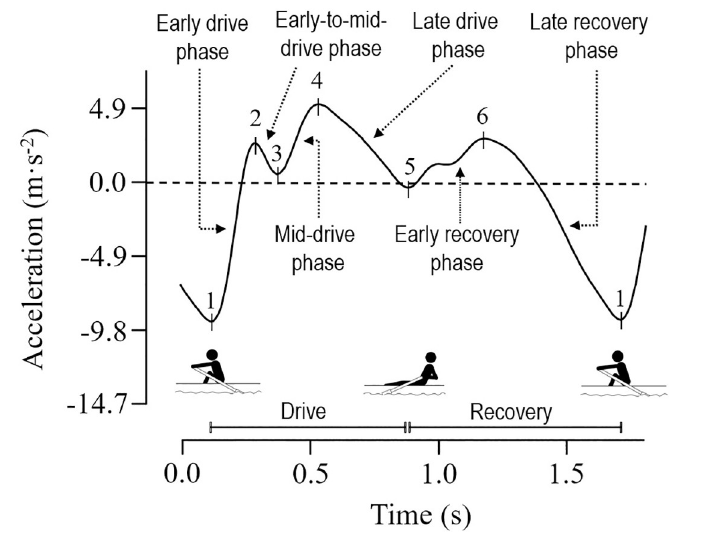
Fig 1. Filtered boat acceleration over a single stroke in a men’s coxless pair at 37.5 strokes � min -1 . 1, maximum negative drive acceleration and the approximate start of drive and end of recovery phases; 2, first peak; 3, first dip; 4, peak drive acceleration; 5, finish dip and the approximate end of drive and start of recovery phases; 6, peak recovery acceleration. The respective phases for the analysis of jerk are: Early drive phase, markers 1 to 2; early-to-mid drive phase, markers 2 to 3; mid-drive phase, markers 3 to 4; late drive phase, markers 4 to 5; early recovery phase, markers 5 to 6; late recovery phase, marker 6 to 1 of the next stroke. Rower position corresponding to the acceleration profile is shown